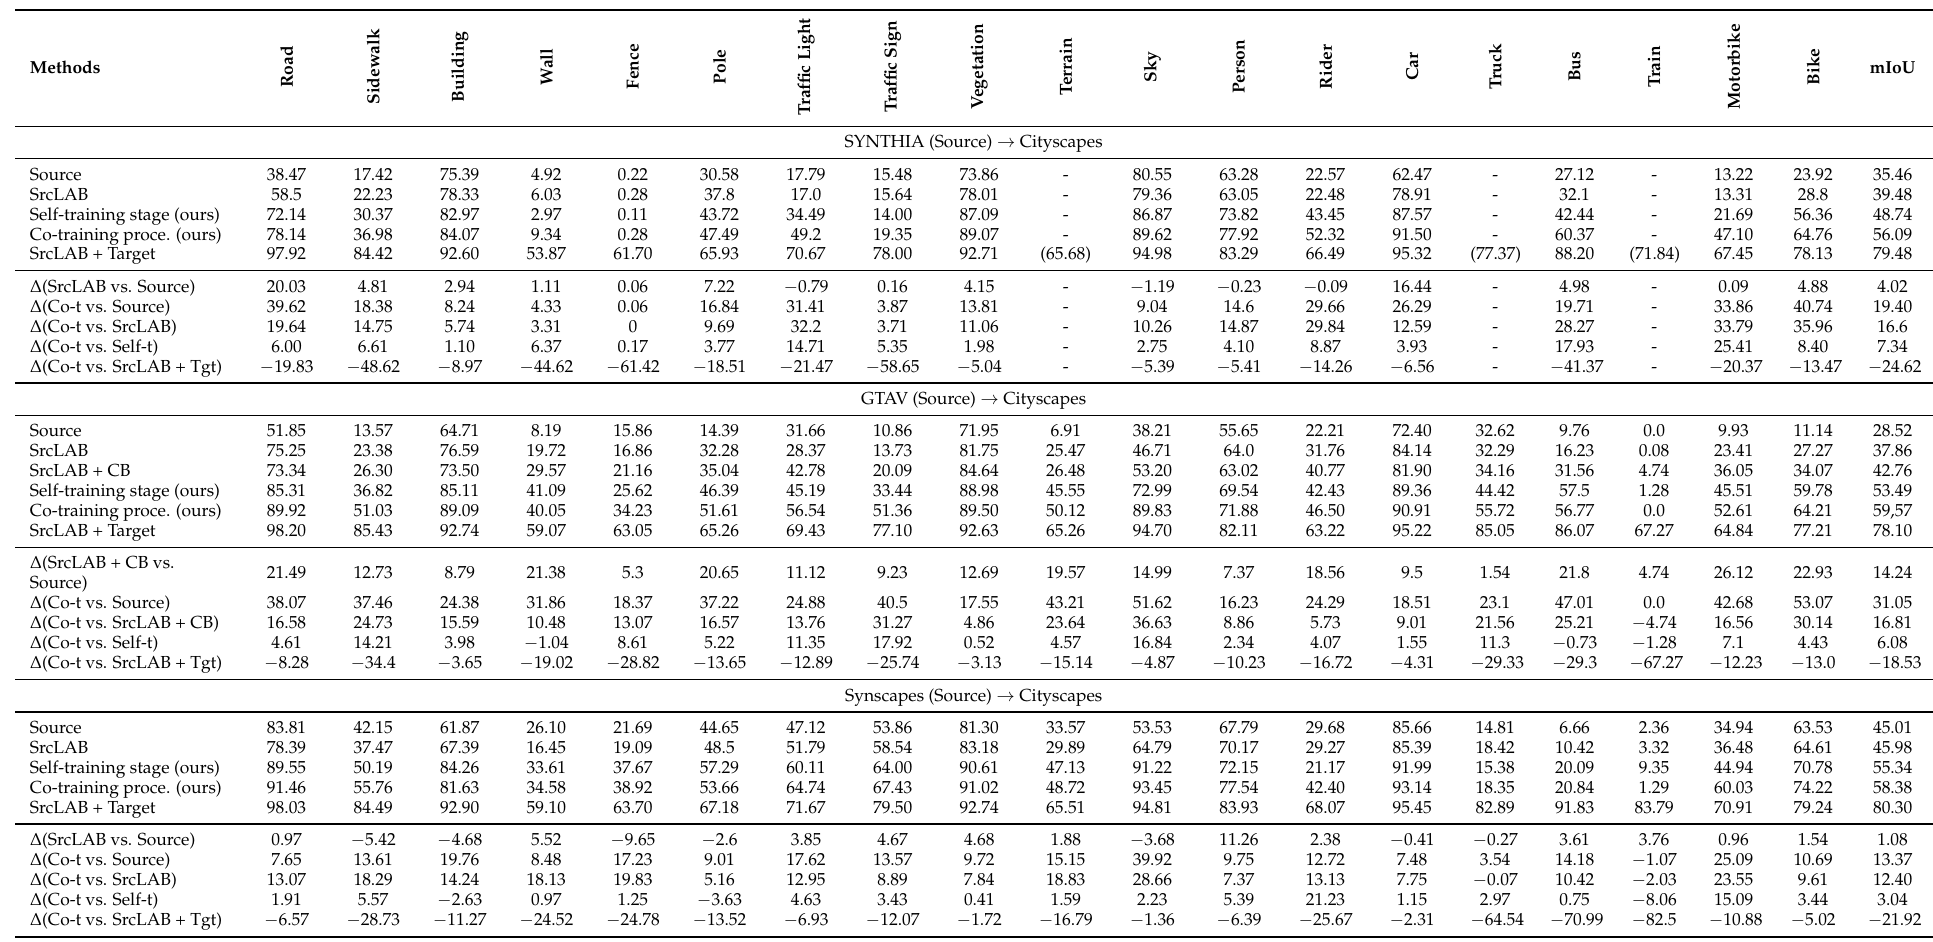
Table 3. Co-training results compared to baseline (Source), LAB adjustment pre-processing (SrcLAB), self-training stage, and upper-bound (SrcLAB + Target). Note that Target refers to using 100% of the target domain images labeled for training by a human oracle. CB corresponds to the class balance policy applied on GTAV. We remind also that, before running our co-training procedure (self-training stage and co-training loop), we apply target LAB adjustment on the synthetic datasets. In this table, the target domain is always